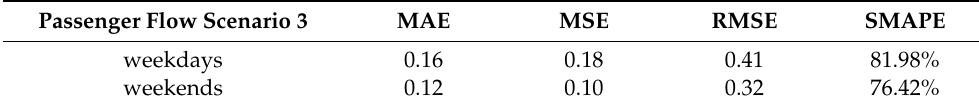
Table 11. The metrics of forecasting results for residential to suburban OD flow.